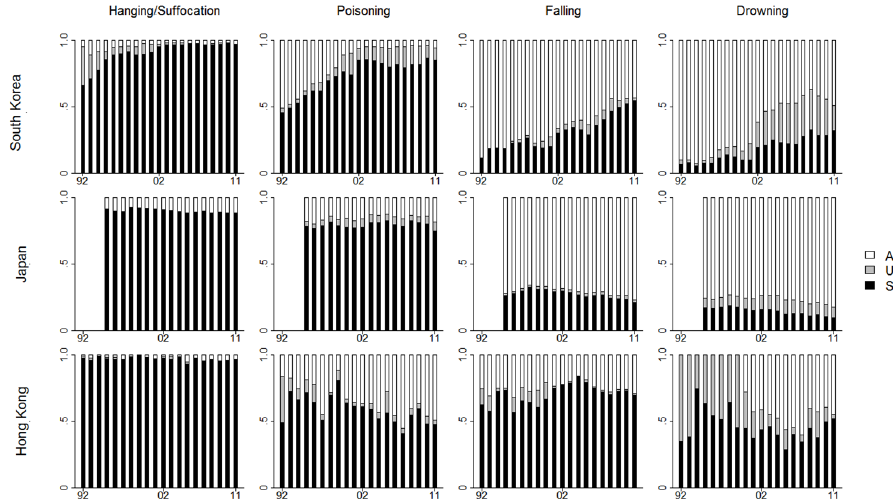
Fig 2. Annual proportional change of suicide, undetermined death, and accident in South Korea, Japan, and Hong Kong stratified by methods from 1992 to 2011.